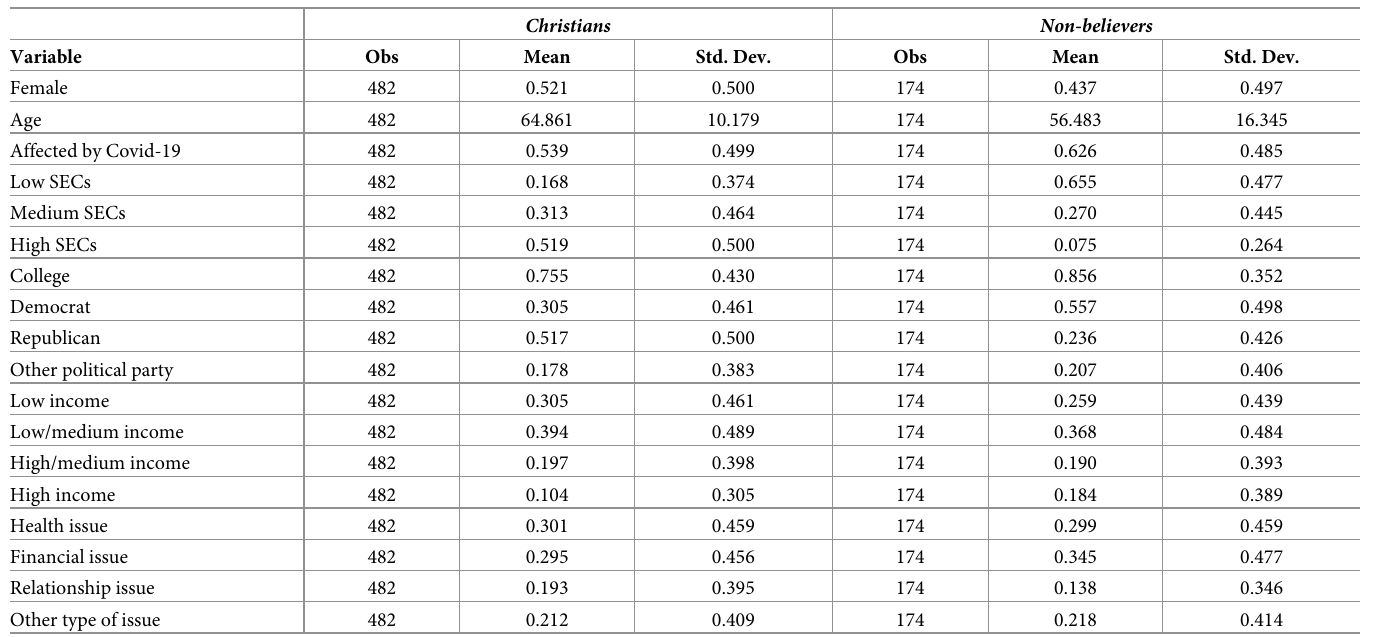
Table 1. Descriptive statistics for Christians and